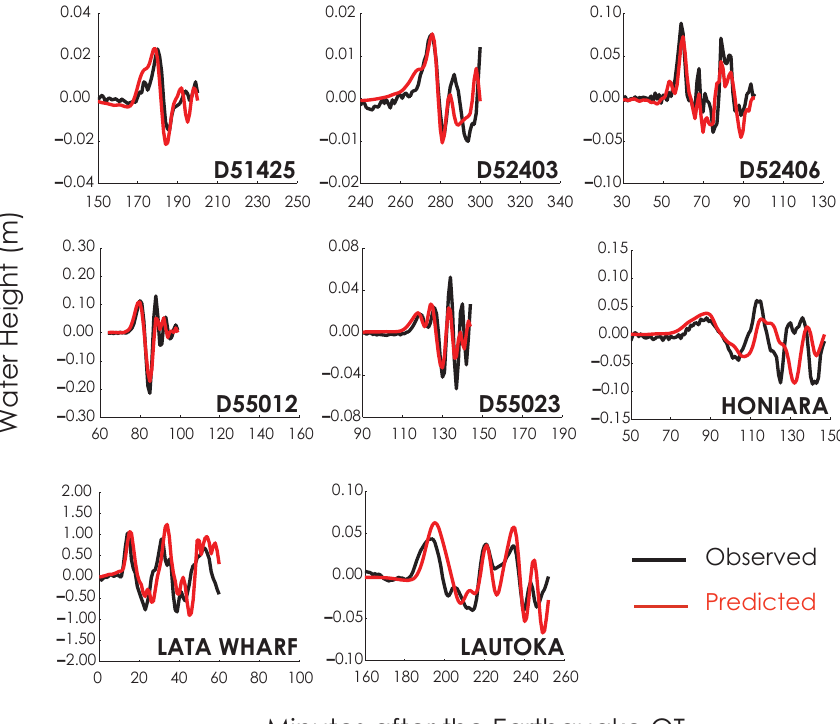
Figure 5. Data fit: comparison between observed (black) and predicted (red) tsunami